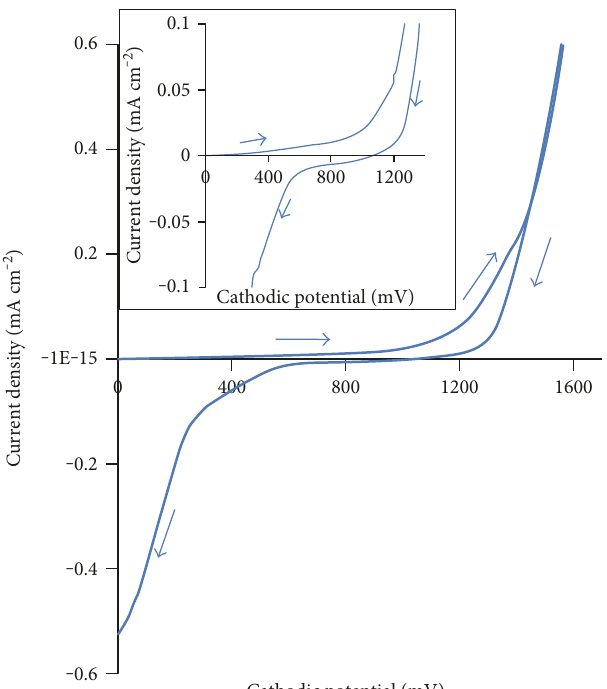
Figure 1: Two-electrode cyclic voltammogram of CdS deposition electrolyte containing 0.3M CdCl and temperature of 80 ± 2 ° C. (Inset shows expansion of the potential axis for